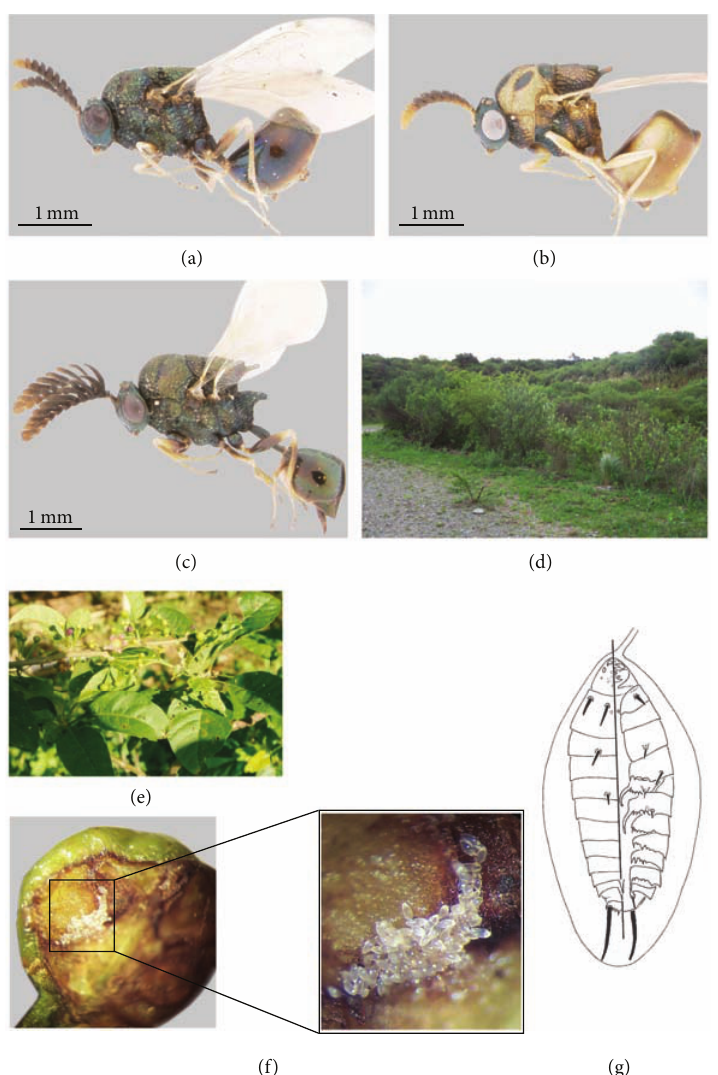
Figure 5: Lophyrocera variabilis : (a) and (b) habitus (female); (c) habitus (male). Biology and immature stages of L. variabilis : (d) habitat; (e) Vasobia breviflora ; (f) saggittal section of unripe fruits of V. breviflora with eggs (egg mass magnified); (g) planidium (before hatching; dorsal and ventral view). Figures 5(a)–5(c), 5(f), and 5(g) are extracted from [26].